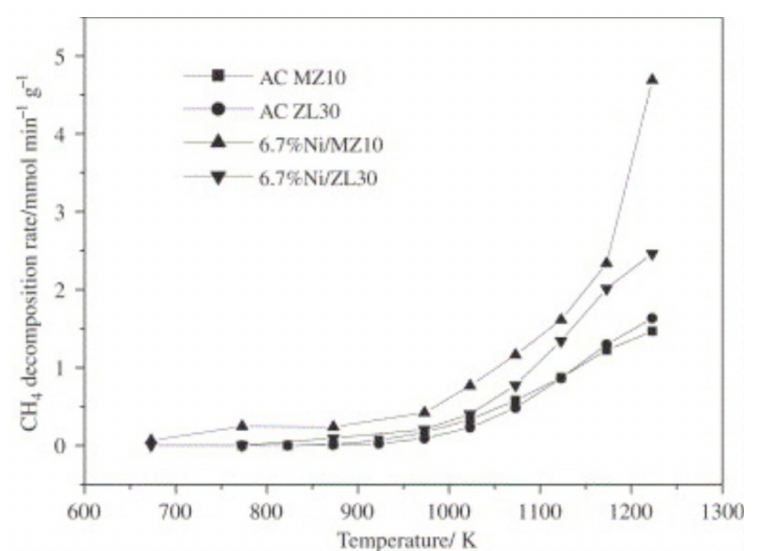
Figure 11. Catalytic activity tests at different operating temperatures of nickel catalysts supported on two commercial activated carbons, AC MZ10 and AC ZL30. reprinted with permission from ref. [96]. Copyright 2007